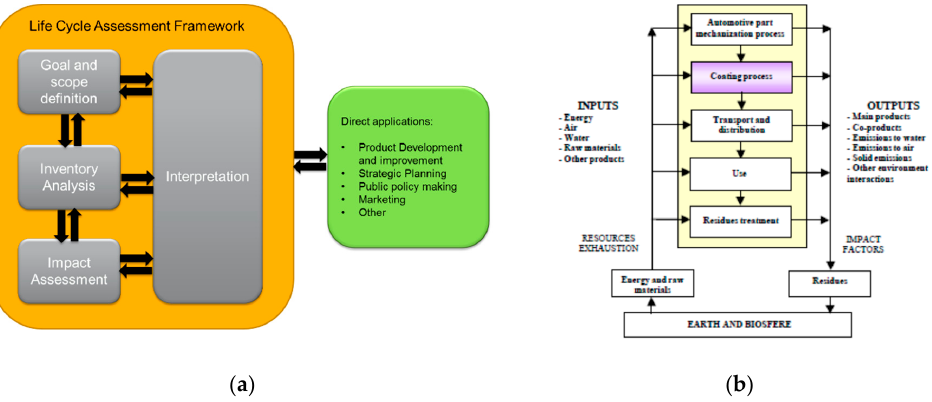
Figure 1. ( a ) Stages or phases of the lifecycle assessment (LCA). ( b ) The lifecycle stages are analyzed by considering energy and raw material transformations during the coating processing of an automotive